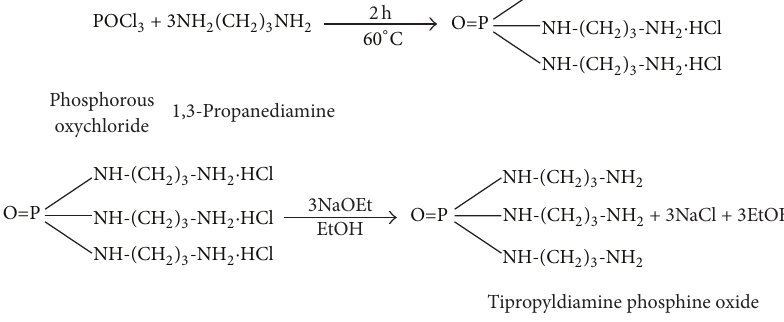
Elemental analysis (Figure 3): calc. %: C: 68.53, N: 5.52, O: 21.65; found %: C: 69, N: 4.74, O: 21; from above chemical analysis structure of PPGE can be